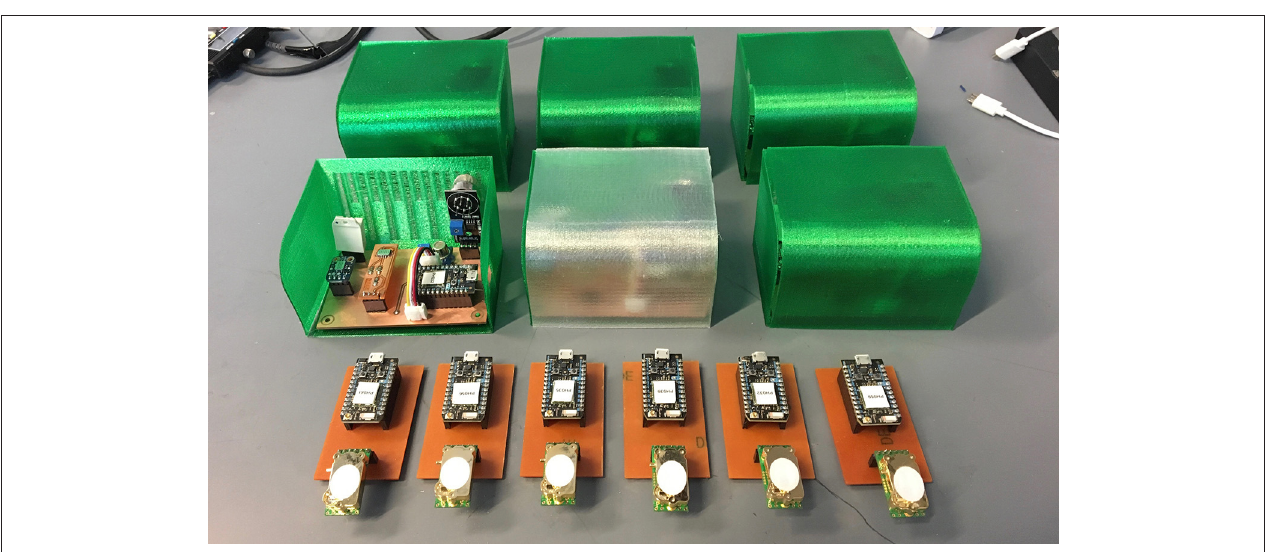
FIGURE 3 | The six multi-iEQ parameter nodes, in their convection blocking enclosures, and six carbon dioxide nodes deployed to buildings on Princeton University’s Campus.